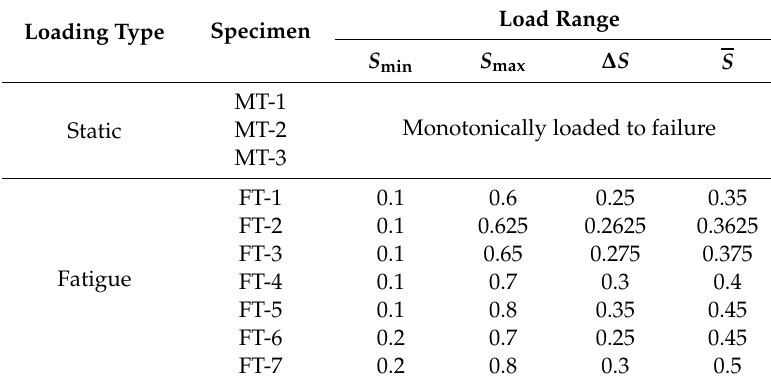
Table 1. Experimental program of static and fatigue